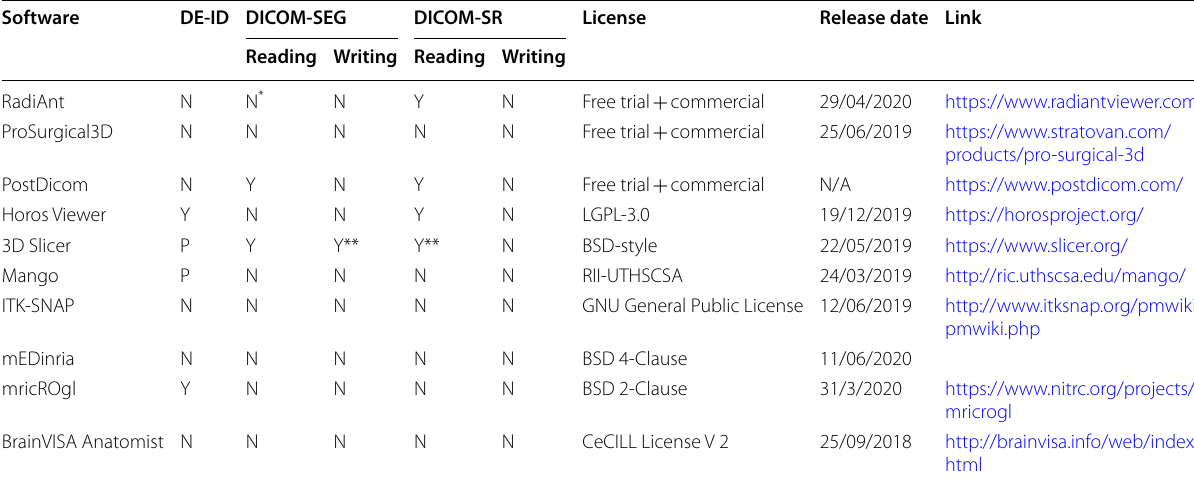
Y, yes; N, no; P, partial * DICOM-SEG successfully loaded but misinterpreted by the software ** Including “QuantitativeReporting” extension (https:// qiicr. gitbo ok. io/ quant itati verep orting- guide/)